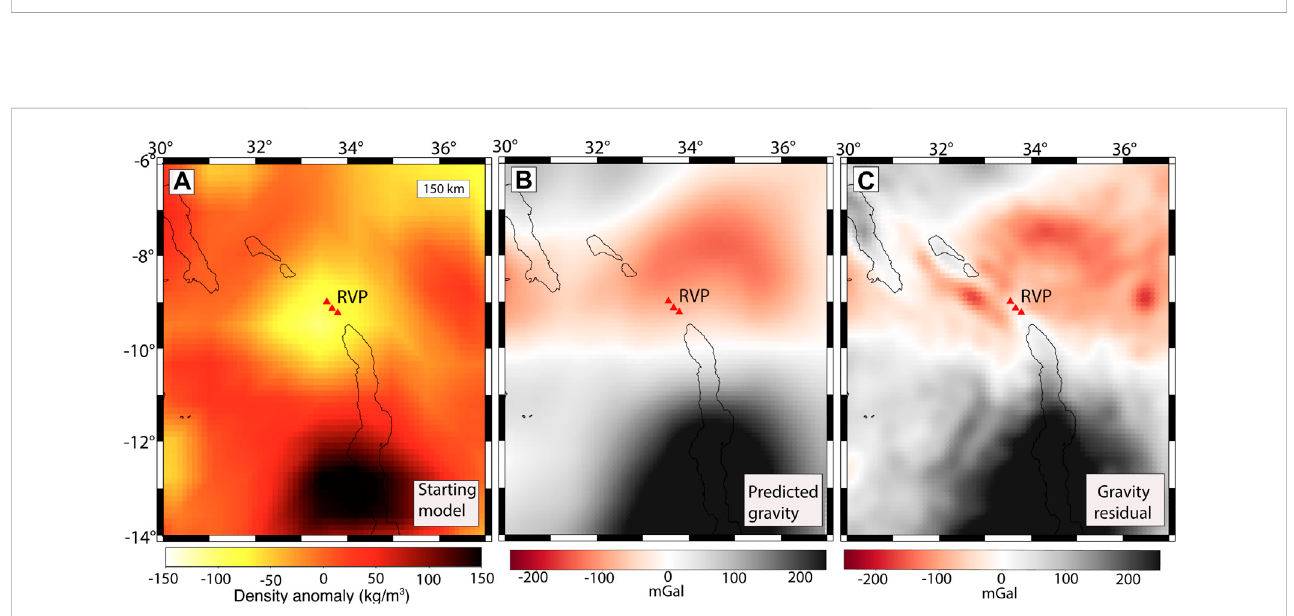
FIGURE 6 (A) A 150 km depth slice of the density anomaly beneath the RVP and surrounding regions based on Eq. 7 assuming strictly temperature control. (B) The predicted gravity anomaly using the derived density anomaly from Eq. 7 as the starting model. (C) The residual gravity, which is the difference between the observed gravity anomalies (Figure 2) and the predicted gravity anomaly (Figure 6B) showing a poor fi t between the predicted and observed gravity